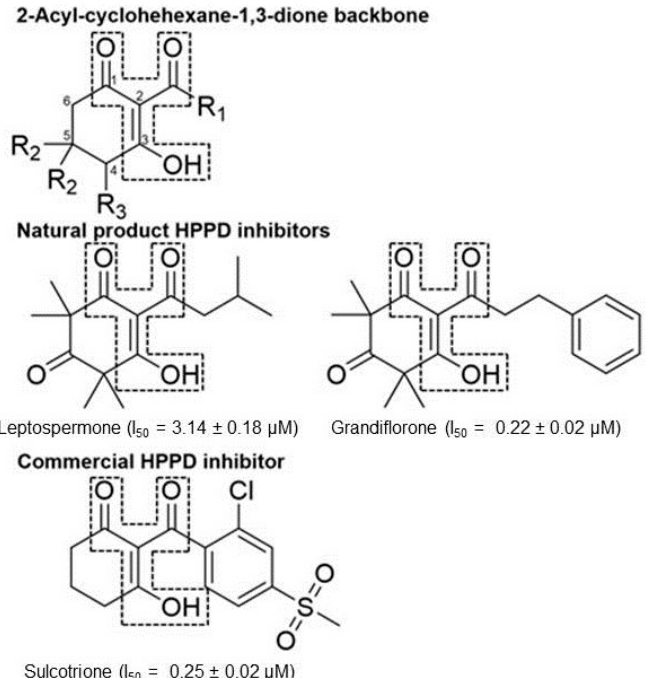
Figure 1. Comparison of the 2-acyl-cyclohexane-1,3-dione backbone to natural product and commercial compounds of known HPPD inhibitory activity. The region within the dashed line represents the triketone moiety containing the 1,3 dione feature required for HPPD inhibitory activity. The ketone group at position 3 undergoes keto-enol isomerization to the form shown at physiological pH. The name of each compound is followed by the I 50 app as tested against recombinant A. thaliana HPPD.